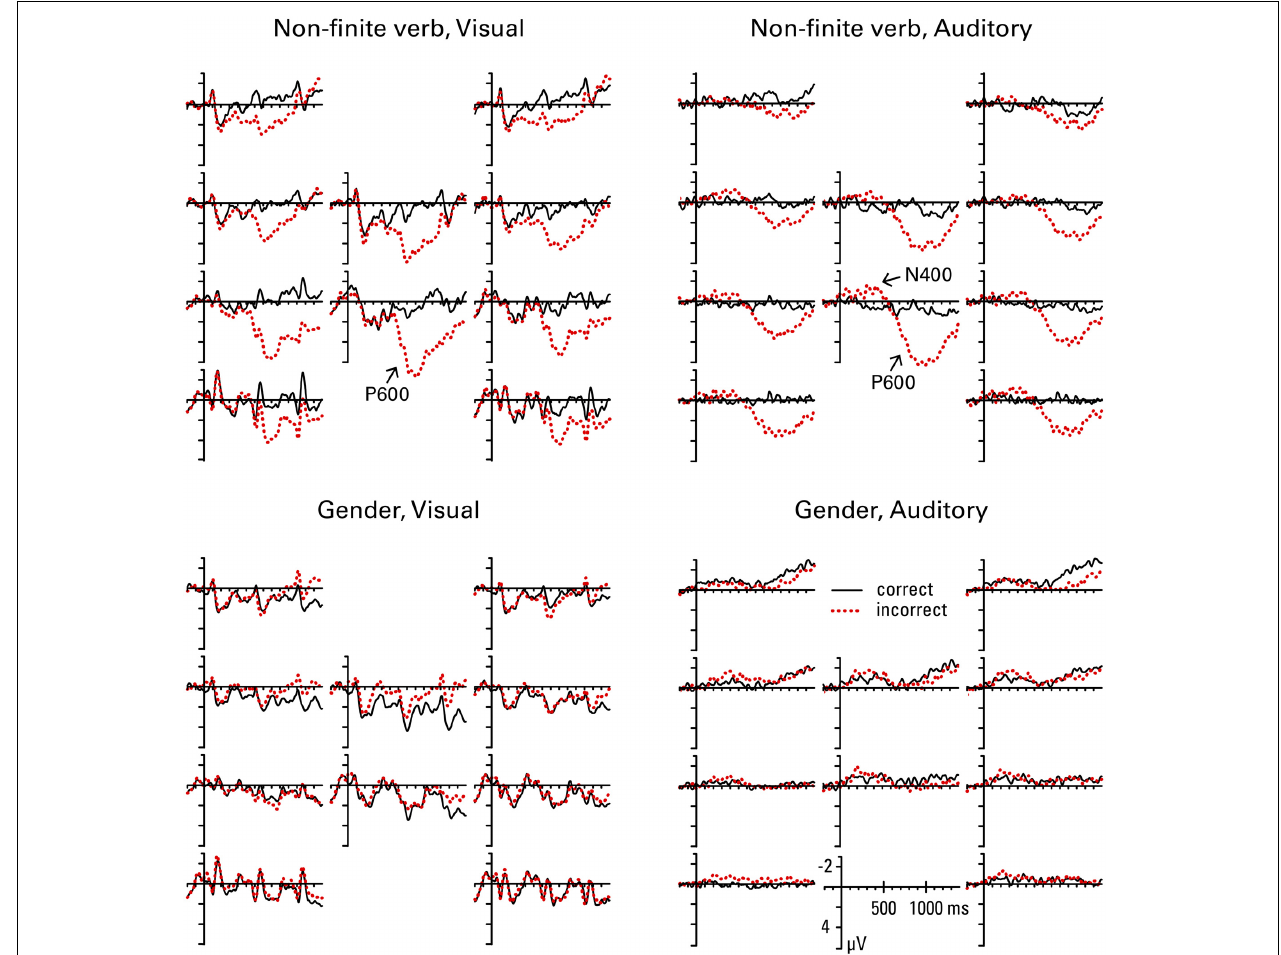
FIGURE 4 | Learners’ grand average ERP waveforms at all 10 regions of interest (see Figure 1) for correct and incorrect use of non-finite verb and gender agreement in the visual and the auditory condition.